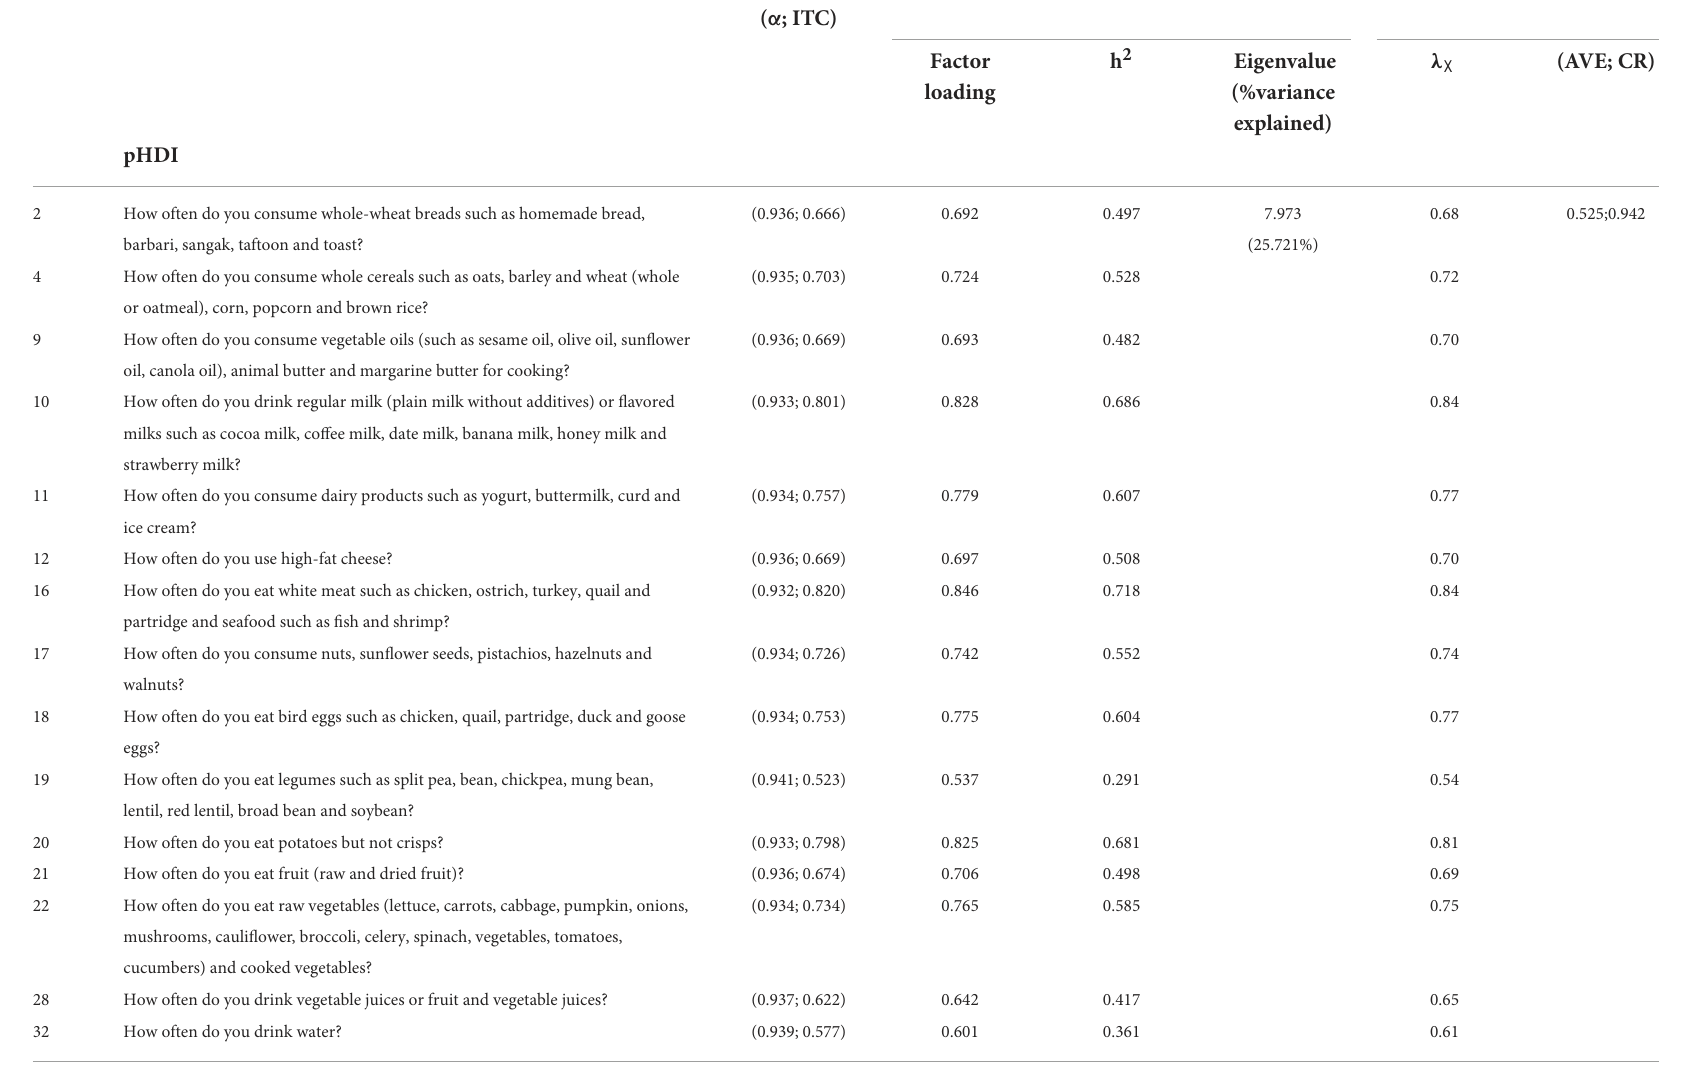
TABLE 2 Exploratory and confirmatory factor analyses of the food frequency consumption scale. No Items Internal